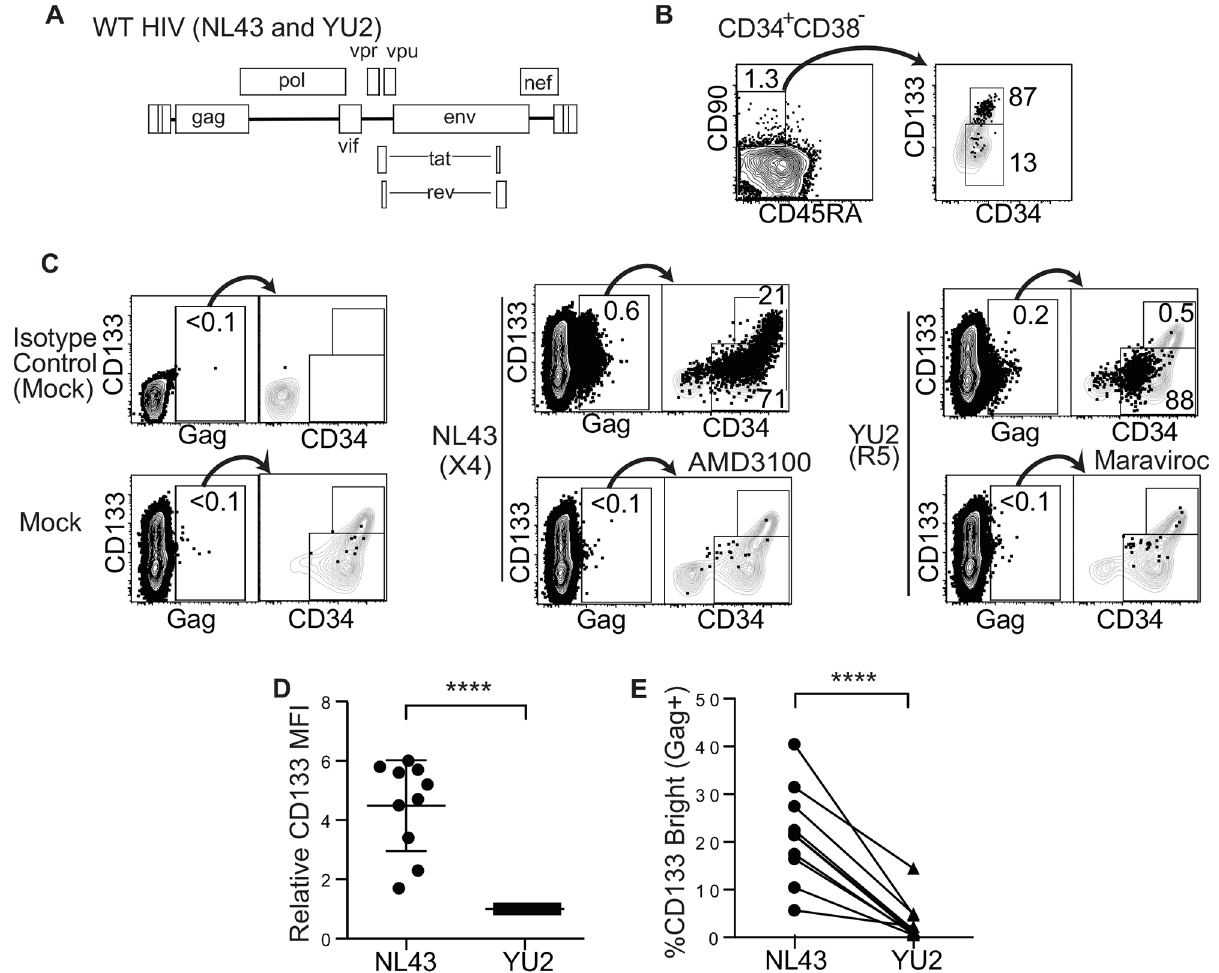
Fig 4. A. Schematic of full-lengthHIV used in C-E. B. Flow cytometric plots of CD133-sortedcord blood HSPCs cultured for 7 days and stained as in Fig 1D. Cells gated in left plot were overlaid on the total live population on the right. C. Representative flow cytometric plots of cord blood-derived CD133-sorted cells expanded for four days, infected with the indicatedvirus and harvested 2 days post-infection. Gag + cells are overlaidonto CD34 versus CD133 plots for the total live cell populationand the percentage of Gag + cells in the CD133 high and CD133 low regions is indicatedin the overlay. D. Summary graph of relativeCD133 expressionby mean fluorescence intensity (MFI) on HSPCs infected with the indicatedHIV. Results were normalized to those for YU-2 infected cells for each experiment. E. Summary graph showingthe frequencyof Gag + cells falling into CD133 bright gate. Data was compiledfrom four cord blood experiments; mean ± standard deviationis indicated( **** p < 0.0001, 2-tailedpairedt-test).